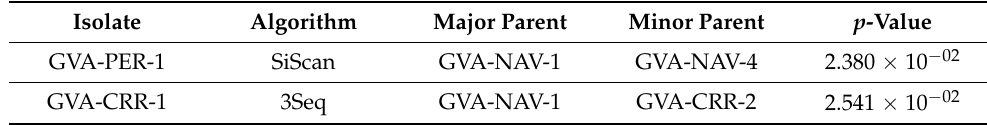
Table 4. Putative recombinant events detected among the Sicilian GVA isolates.